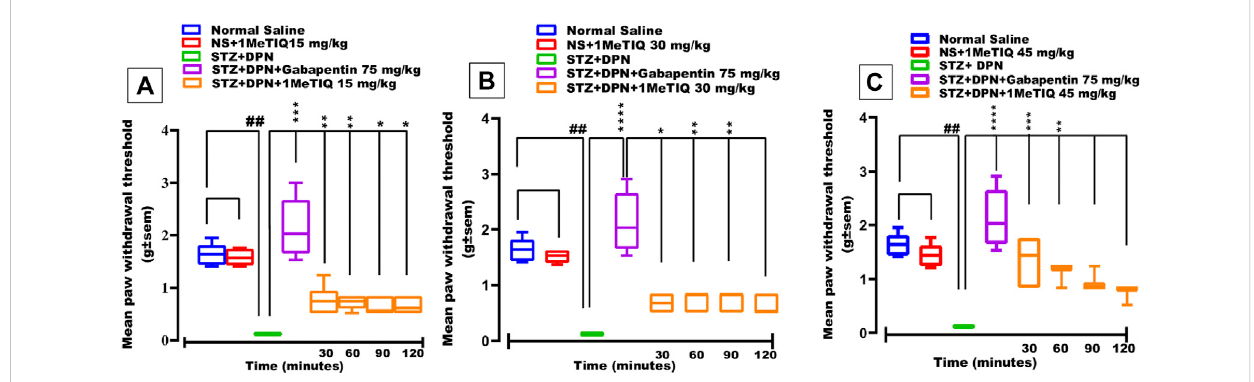
FIGURE 1 Effect of 1-Methyl-1,2,3,4-tetrahydroisoquinoline (15, 30 and 45 mg/kg i.p.) or gabapentin (75 mg/kg) on STZ-induced diabetic static mechanical allodynia (von Frey fi lament applied paw withdrawal pressure; PWT). Four weeks after STZ administration, mice displayed markedly decreased responses to nociception and they also became allodynic (A, B) and (C) , an effect that was overcome by both gabapentin and 1MeTIQ. Data were presented as mean ± SEM and the abscissa coordinate represents the time after treatment. * p < 0.05, ** p < 0.01, **** p < 0.0001 when compared to the STZ + DPN group.